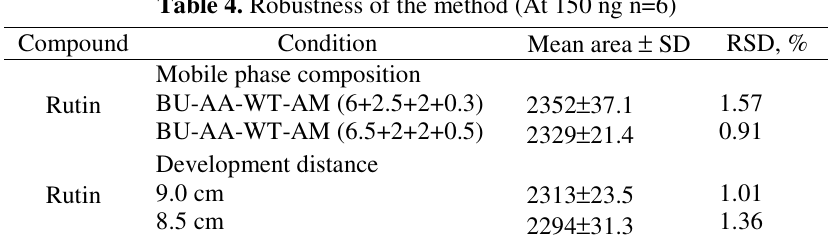
Table 4. Robustness of the method (At 150 ng